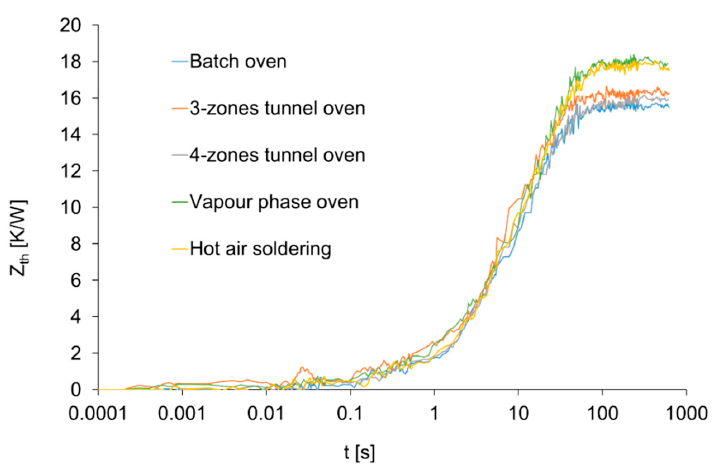
Figure 6. Transient thermal impedance waveforms of NGB8207BN transistors soldered onto FR4 substrate in different soldering ovens. substrate in different soldering